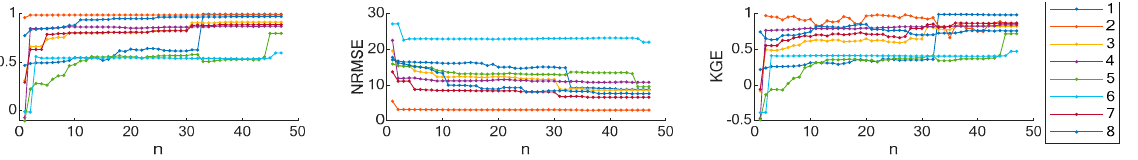
Figure 6. The LM model performance ( CC , NRMSE , and KGE ) depending on the number of input variables (n) form the ERA dataset in the validation phase. 1—air surface pressure (hPa), 2—air temperature ( ◦ C), 3—incoming photosynthetically active radiation ( µ mol/m 2 /s), 4—relative air humidity (%), 5—wind speed (m/s), 6—wind direction (deg), 7—net radiation (W/m 2 ), 8—soil temperature at 5 cm ( ◦ C).